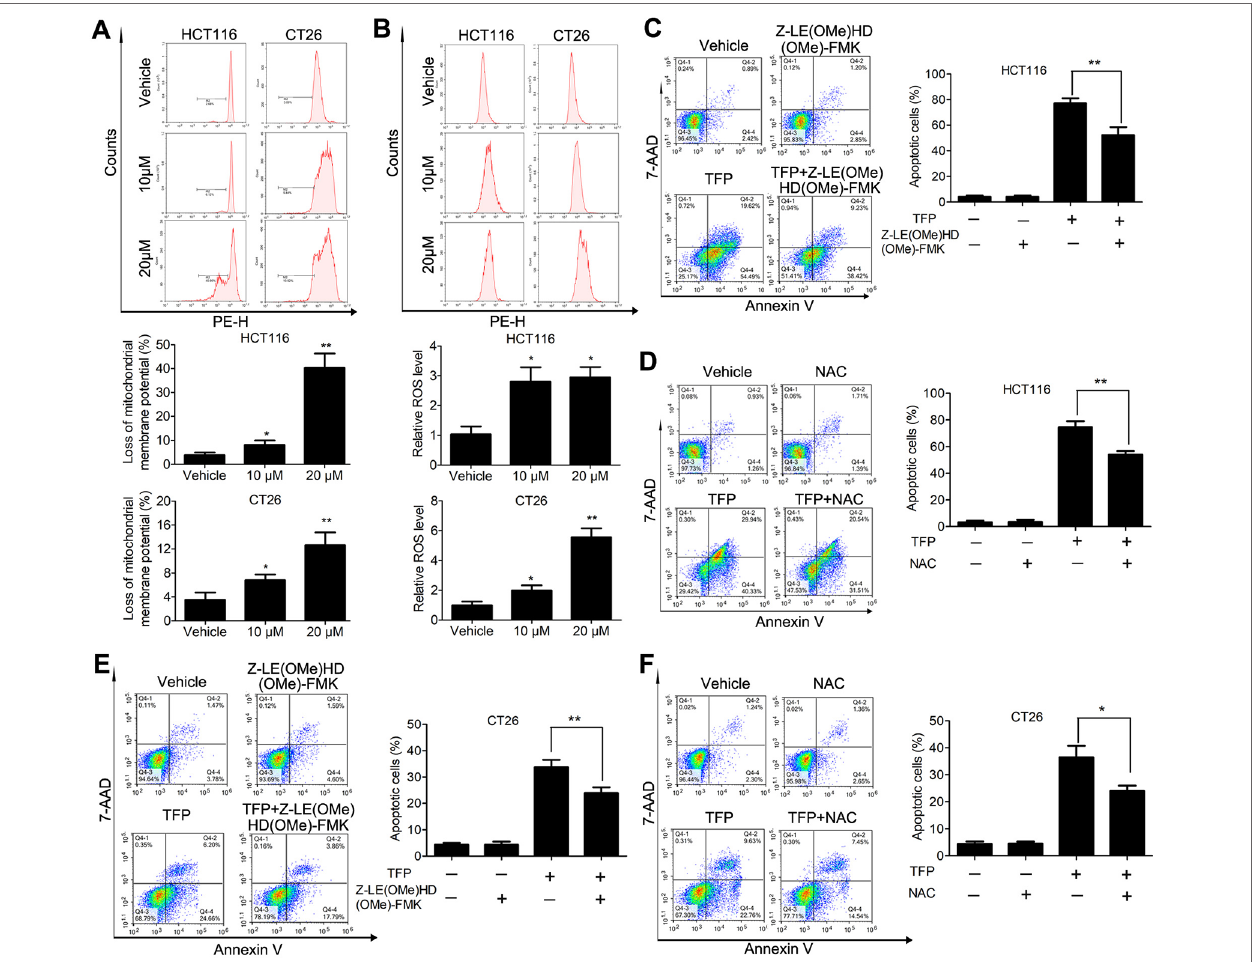
FIGURE 6 | Effects of TFP on the mitochondria-mediated intrinsic apoptosis pathway. (A) TFP decreased Δ Ψ m of HCT116 and CT26 cells. The cells were treated with TFP (10 or 20 µM) for 24 h and then incubated with Rh123 to detect the change of Δ Ψ m by FCM. Quantified changes of Δ Ψ m based on three independent experiments were shown below the images. (B) TFP treatment elevated ROS levels in HCT116 and CT26 cells. After treatment with TFP (10 or 20 µM) for 24 h, the cells were stained with 10 µM DCFH-DA. The cellular ROS levels were detected by FCM. Quantified ROS levels based on three independent experiments were shown below the images. (C) HCT116 cells were treated with 20 µM TFP alone or in combination with Z-LE(OMe)HD(OMe)-FMK (caspase-9 inhibitor) for 48 h. Then, the apoptosis of the cells was measured by FCM after Annexin V-PE and 7-AAD labeling. Quantified values are shown to the right. (D) HCT116 cells were treated with 20 µM TFP alone or in combination with NAC for 48 h. Then, the apoptosis of the cells was measured. (E) CT26 cells were treated with 15 µM TFP alone or in combination with Z-LE(OMe)HD(OMe)-FMK for 24 h. Then, the apoptosis of the cells was measured. (F) CT26 cells were treated with 7.5 µM TFP alone or in combination with NAC for 48 h. Then, the apoptosis of the cells was measured. *P < 0.05, **P <